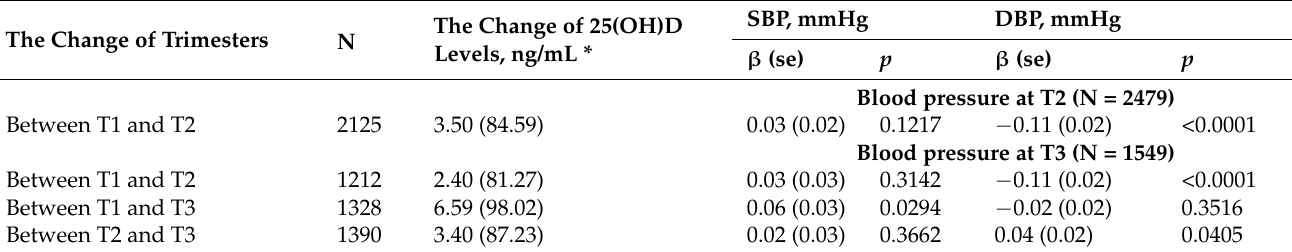
Table 3. The association between the change of 25(OH)D levels during pregnancy and blood pressure at T2 and T3.